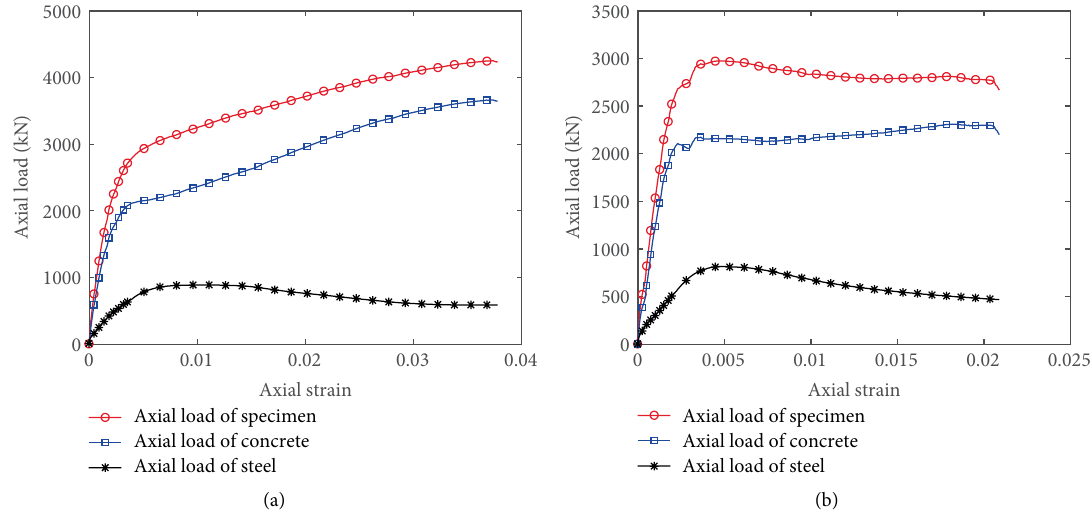
Figure 9: Axial load taken by the concrete and the steel tube. (a) EC2-ec2-F6. (b)